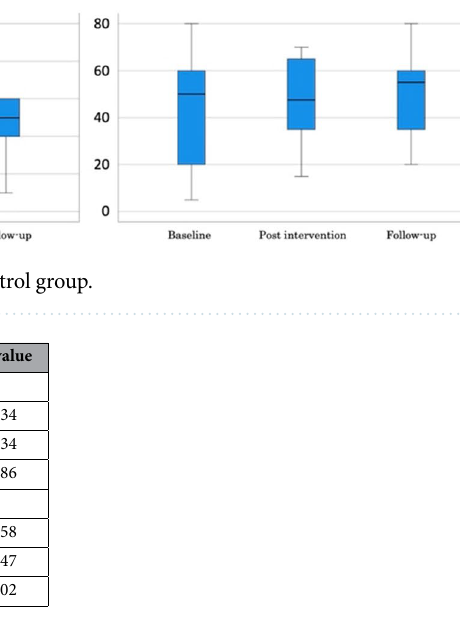
Table 2. Comparison of each palpation score at post-intervention and follow-up.